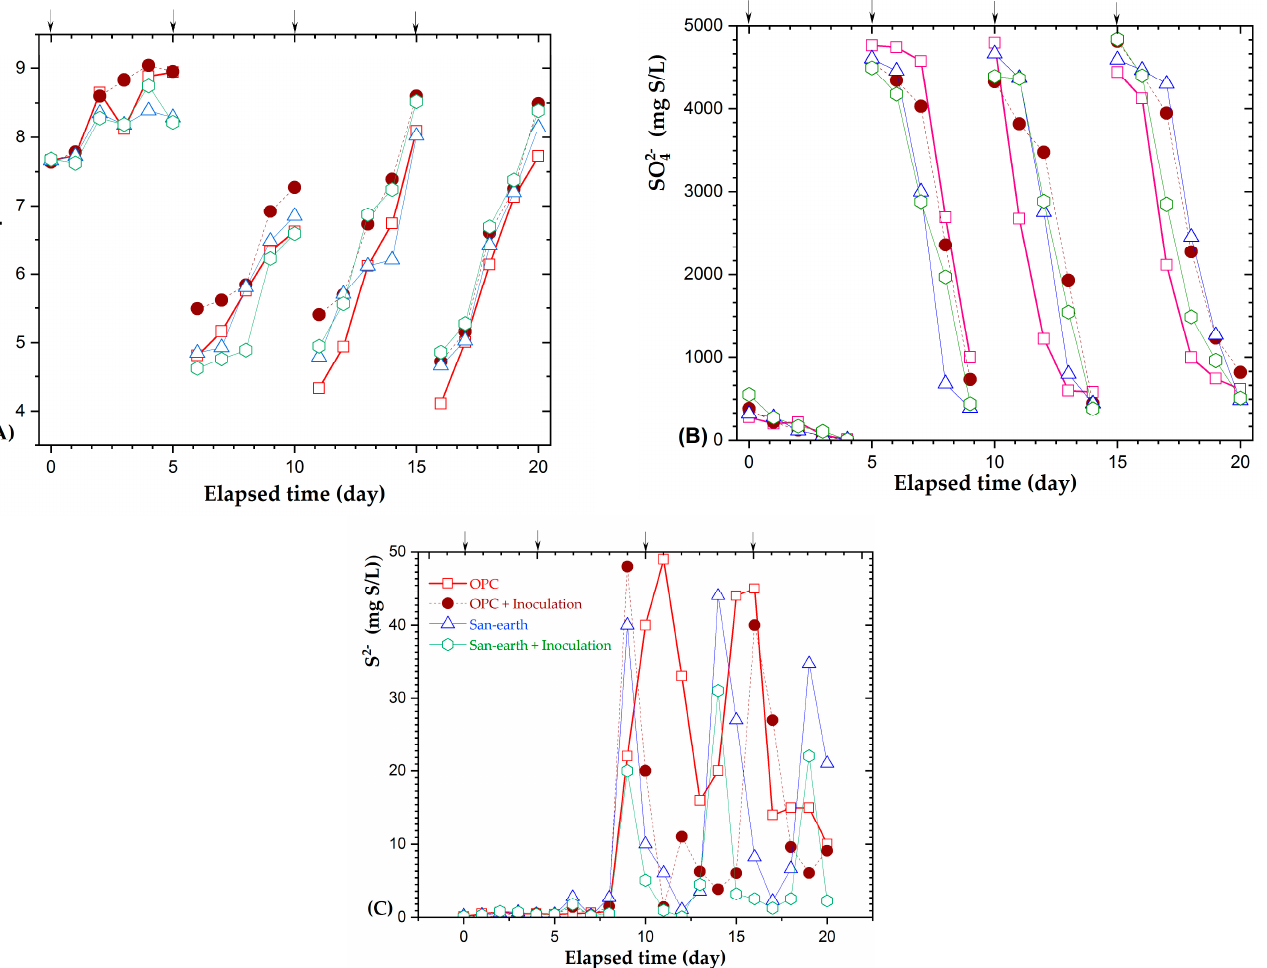
Figure 6. Effects of the EPB inoculation on the pH ( A ) and sulfate ( B ), and sulfide concentrations ( C ). The arrows ( ↓ ) indicate the addition of glucose and magnesium sulfate; 1000 mg/L of glucose and 500 mg S/L of sulfate ion were added at the start of the experiment, and 10,000 mg/L of glucose and 5000 mg S/L of sulfate ion were added on days 5, 10, and 15.